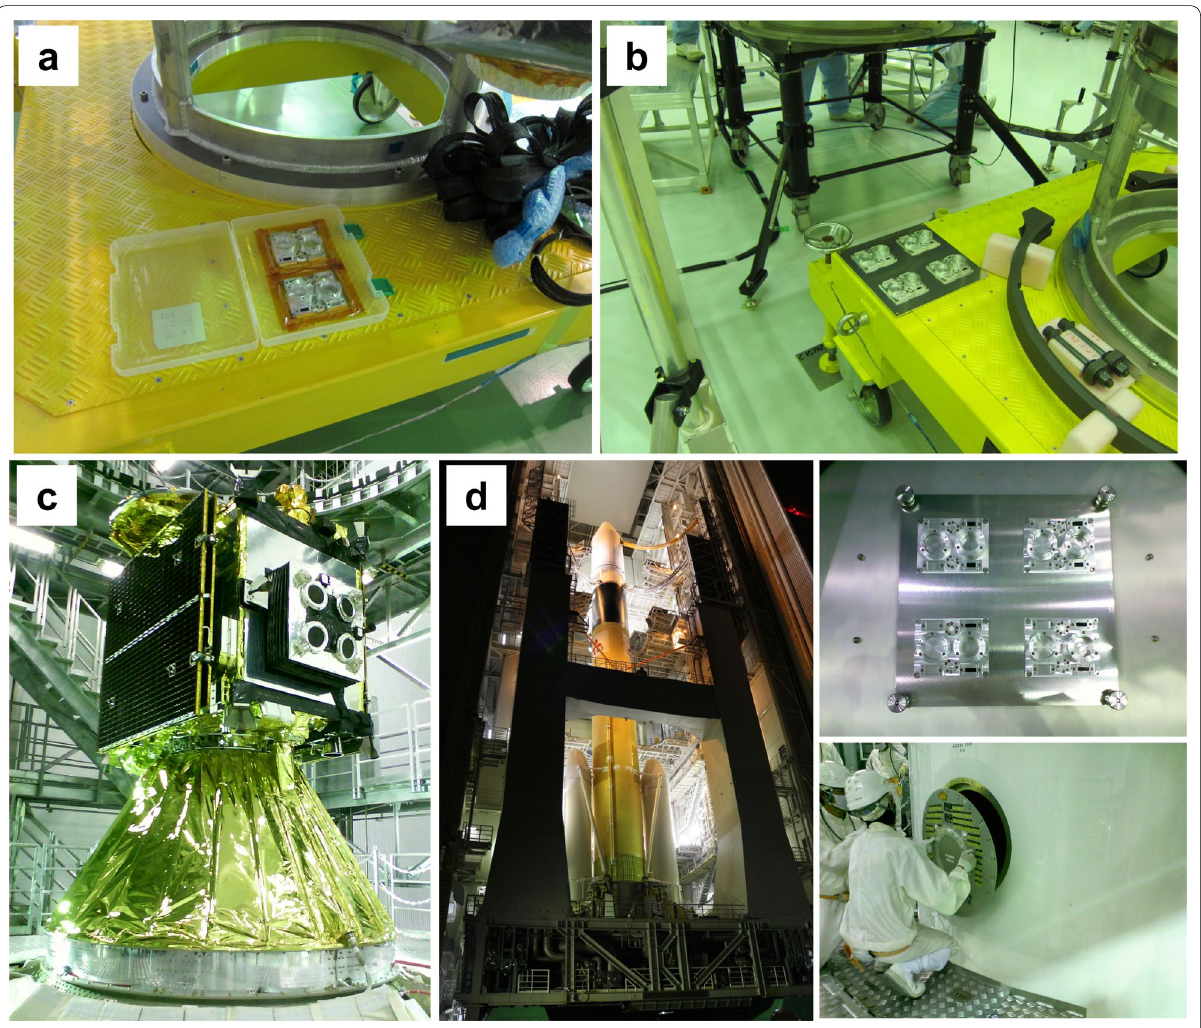
Fig. 2 Representative snapshots of the environmental assessment. a Practical deployment of the monitor coupon in the processes of ISAS (ISAS-C building clean room) and TSC (JAXA Tsukuba Space Center), b STA1 building clean room at TNSC (JAXA Tanegashima Space Center), c SFA2 building clean room, d VAB building clean room at TNSC, and e , f the final launch site at TNSC. When moving to the TNSC monitored with coupon set #5, the continuous flow of nitrogen was temporarily stopped due to logistical reasons, and then the nitrogen purge state (i.e., without exposure time of ambient atmosphere) was maintained by sealing the